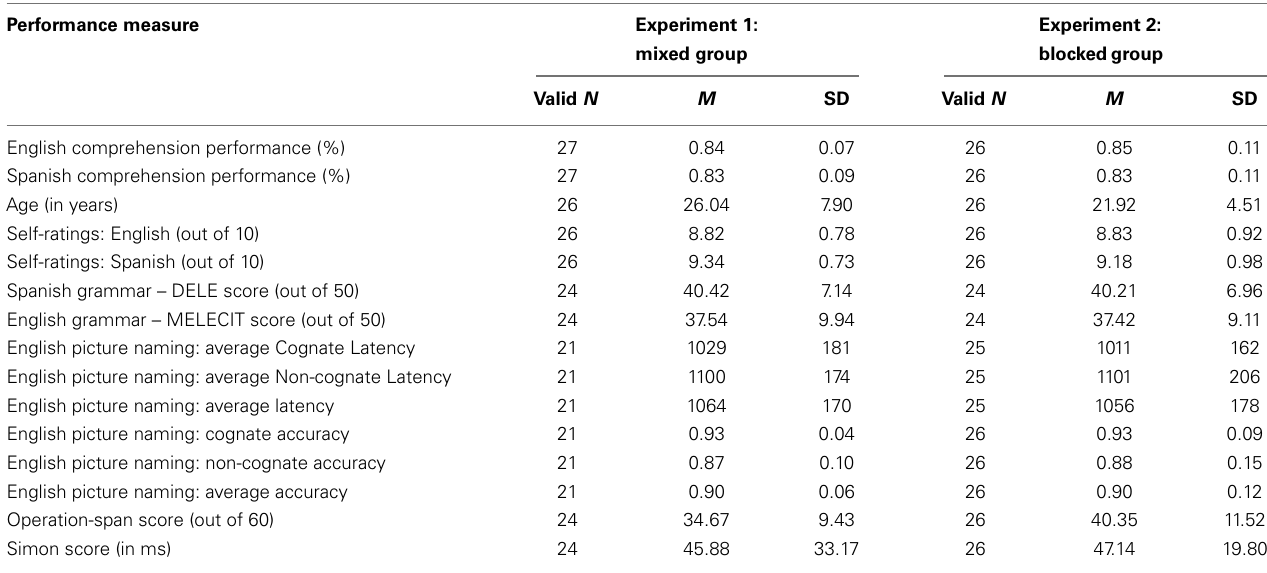
Table 1 | Participant